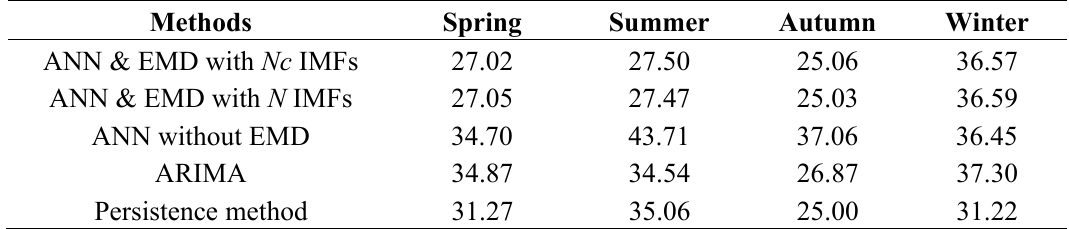
Table 5. MAE of forecasted wind power (kW) obtained by various